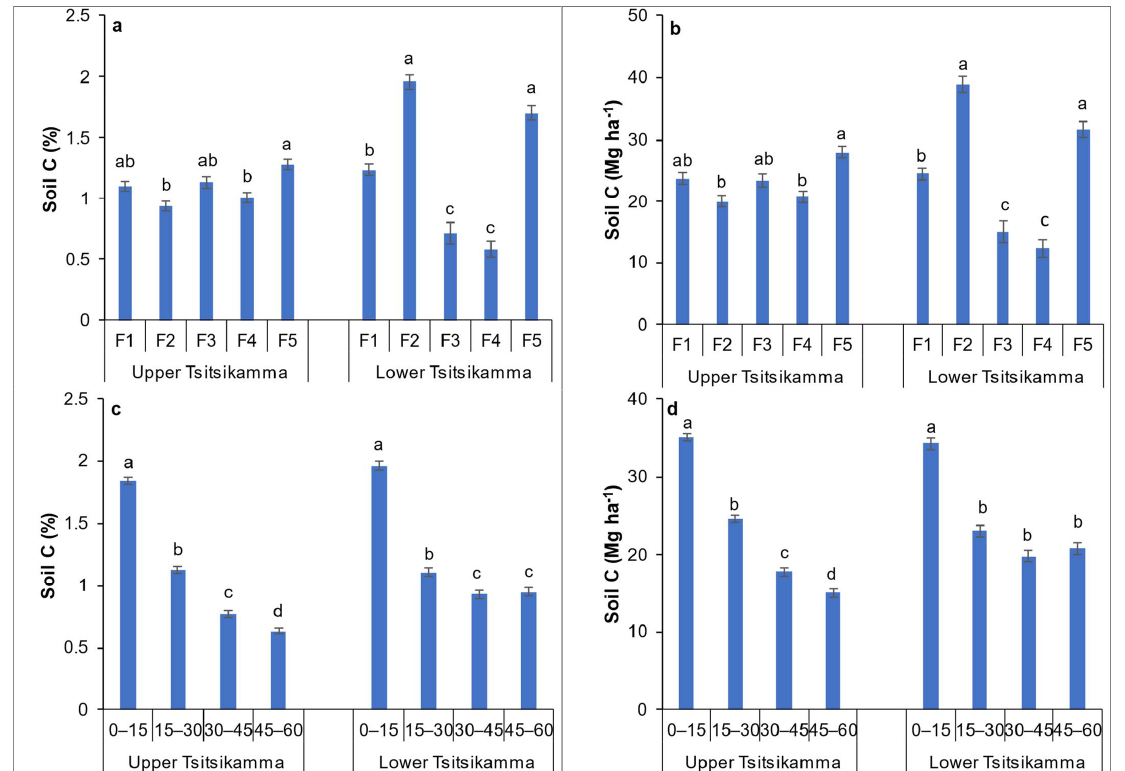
Figure 3. Effects of different farm management ( a , b ) and soil depth ( c , d ) on total C contents ( a , c ) and stocks ( b , d ) under mixed pastures in the Tsitsikamma dairy farms. Error bars indicate standard error of means. Different letters per site indicate significant